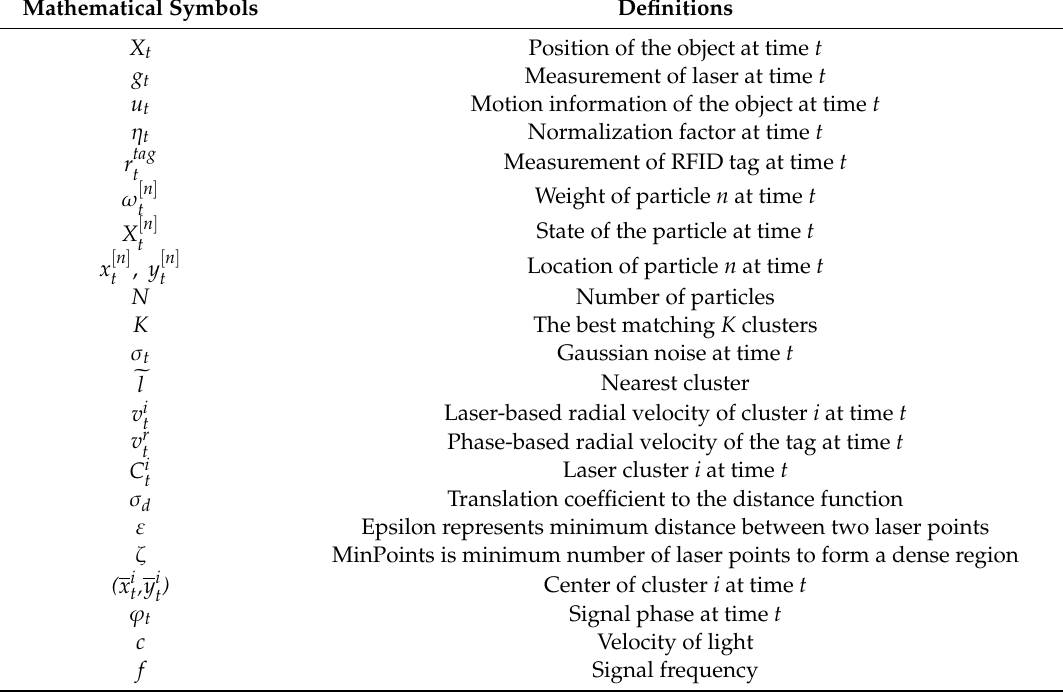
Table 2. Definition of mathematical